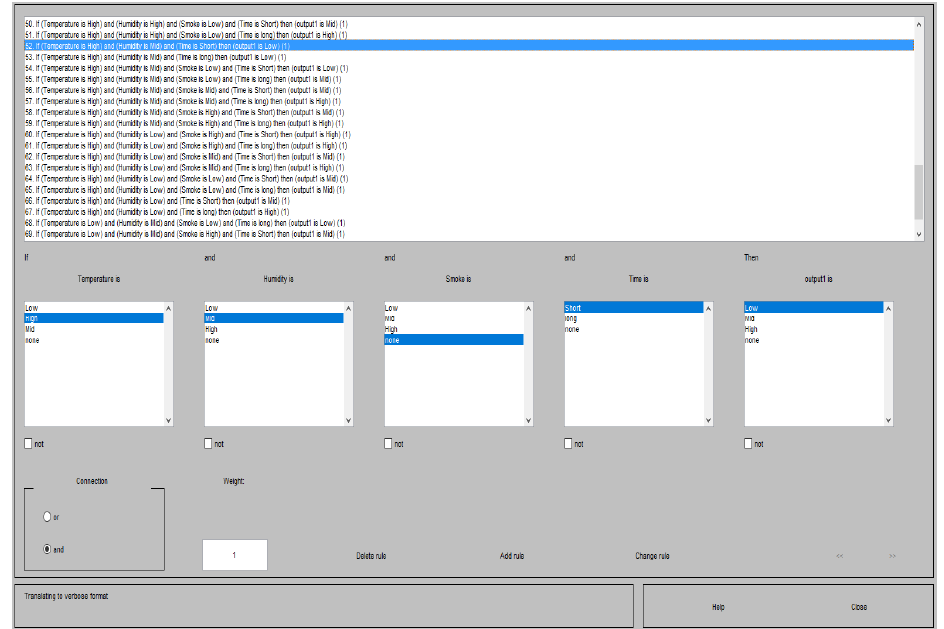
Figure 22. Rule Editor for SMDD.